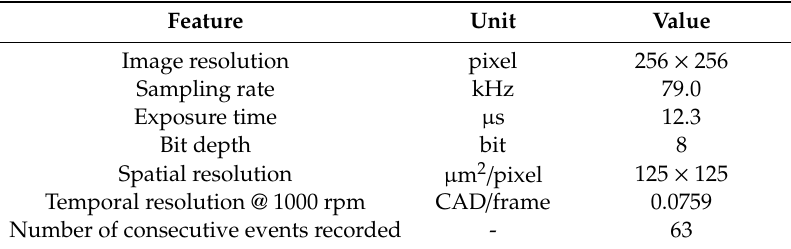
Table 3. High-speed camera